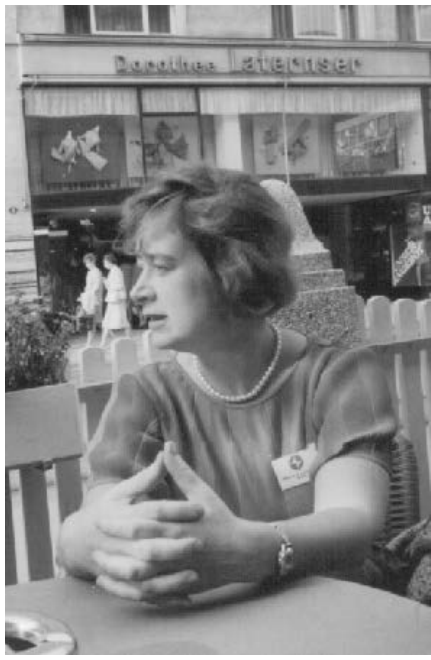
Figure 3. Elena Lyubomova (USSR delegate) at the General As- sembly in Zurich. Note the badge with the IUGG logo used for the first time (photo: courtesy of Seiya